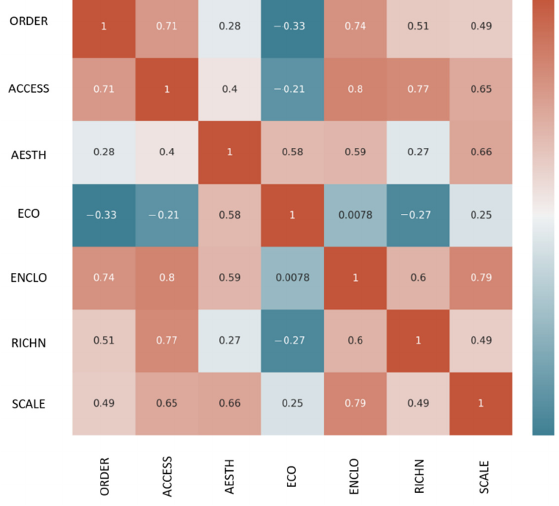
Figure 7. Pearson’s correlation of 7 perceptions.